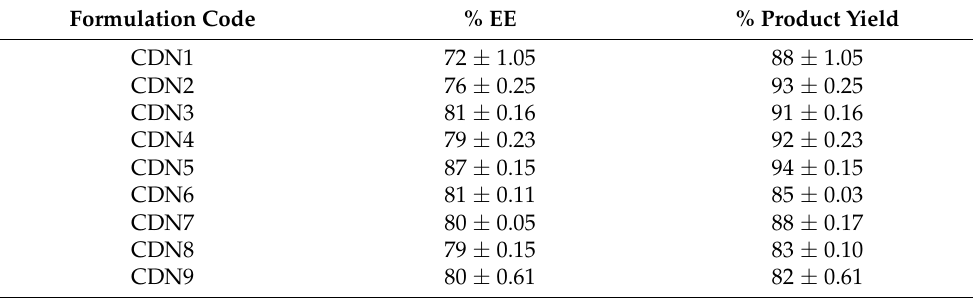
Table 2. % EE and Product yield of polymeric nanobeads (Mean ± SD, n = 5). Formulation Code